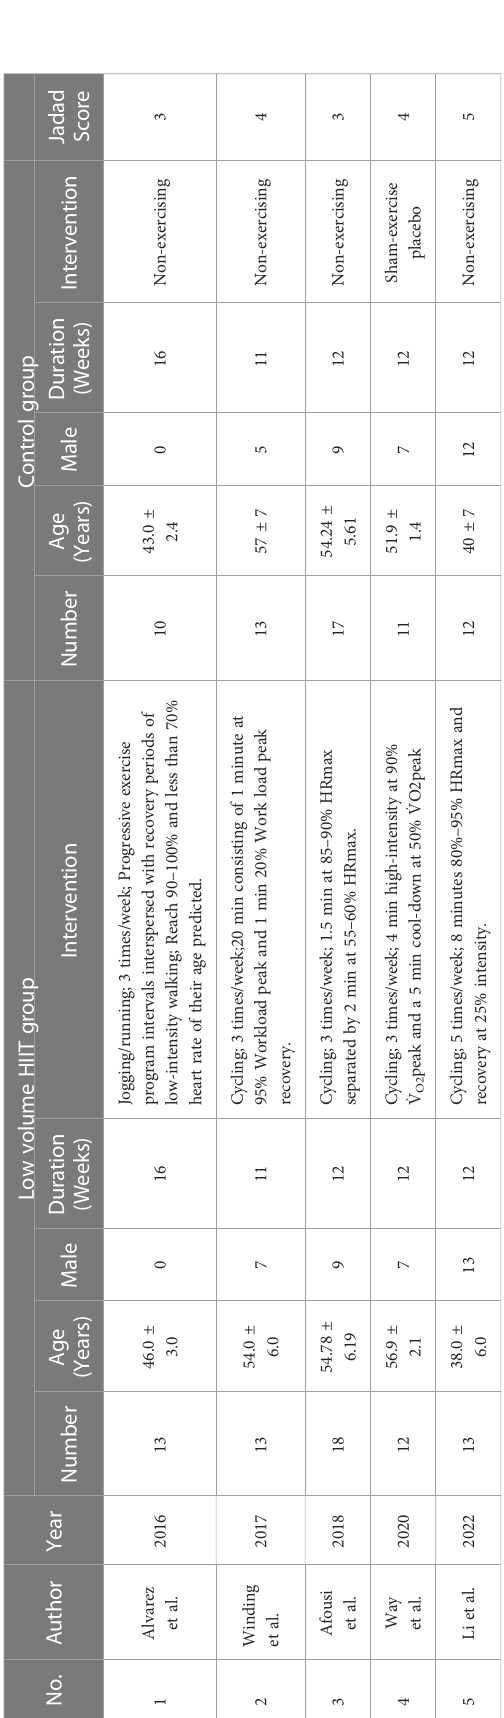
All fi ve studies included the SBP and DBP (10, 25 – 28). Our results indicated that LVHIIT can reduce the SBP (RR =-4.01, 95% CI = -4.82 – -3.21, p<0.0001; Figure 8A) but not DPB (RR =-1.52, 95% CI = -3.31 – 0.26, p=0.09; Figure 8B) with nonsigni fi cant T